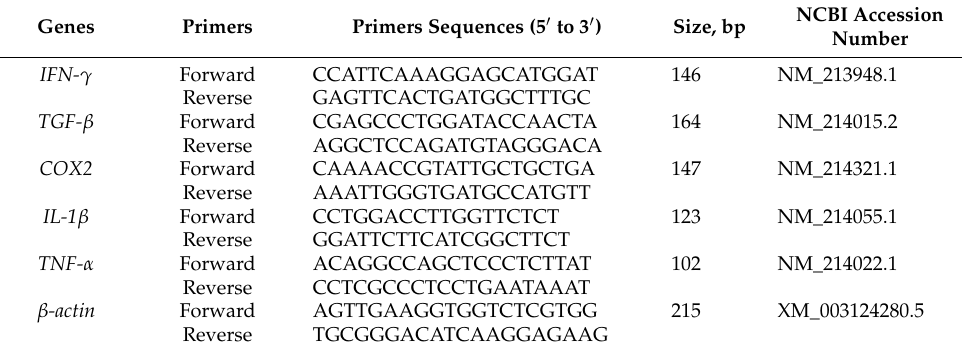
Table 2. Primers used for real-time quantitative PCR